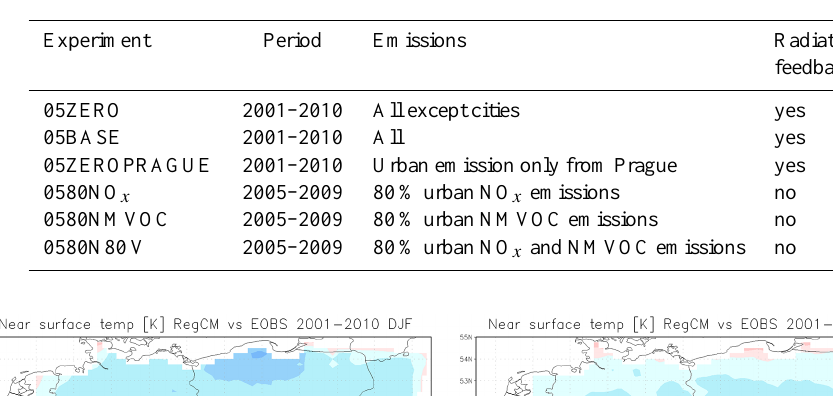
Table 1. Summary of the conducted experiments including the experiment name, the time period, the emissions considered and whether radiative feedbacks on meteorology are considered.